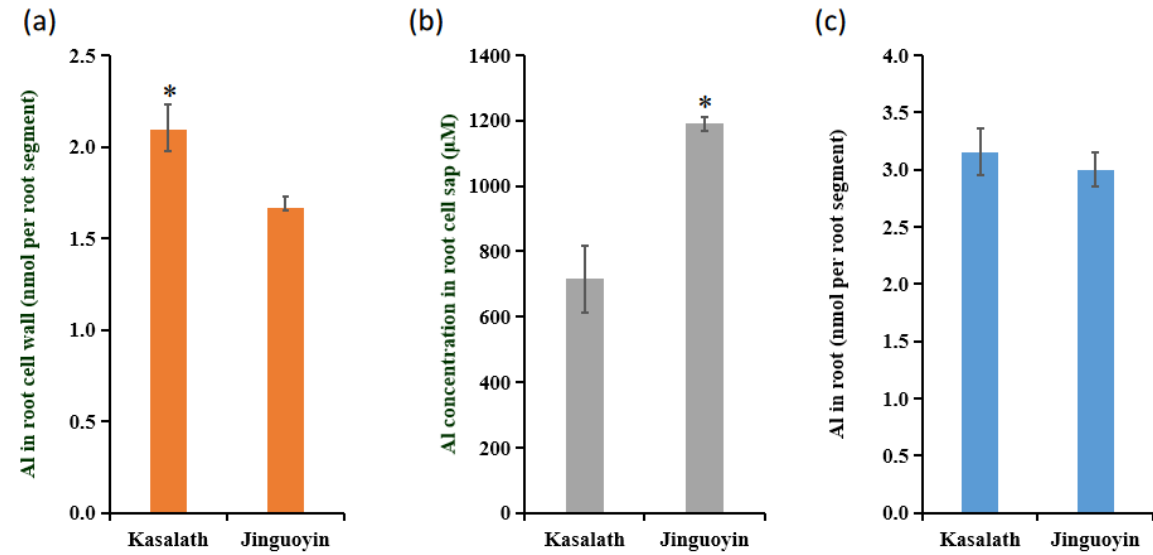
Figure 4. Al accumulation in the root tips. ( a ) Root tip cell wall Al content; ( b ) root tip cell sap Al concentration, and ( c ) total root tip Al content of two indica cultivars. Four-day-old seedlings were exposed to a 0.5 mM CaCl 2 (pH 4.5) solution containing 50 μM Al for 24 h. Then, the root tips (0–1 cm) were excised and the cell wall and cell sap were fractioned. Al concentration was determined by Inductively coupled plasma mass spectrometry. Data are mean ± SD (n = 3). Asterisks (*) indicate significant differences between Kasalath and Jinguoyin at p -values of <0.05 by the Student’s t -test.